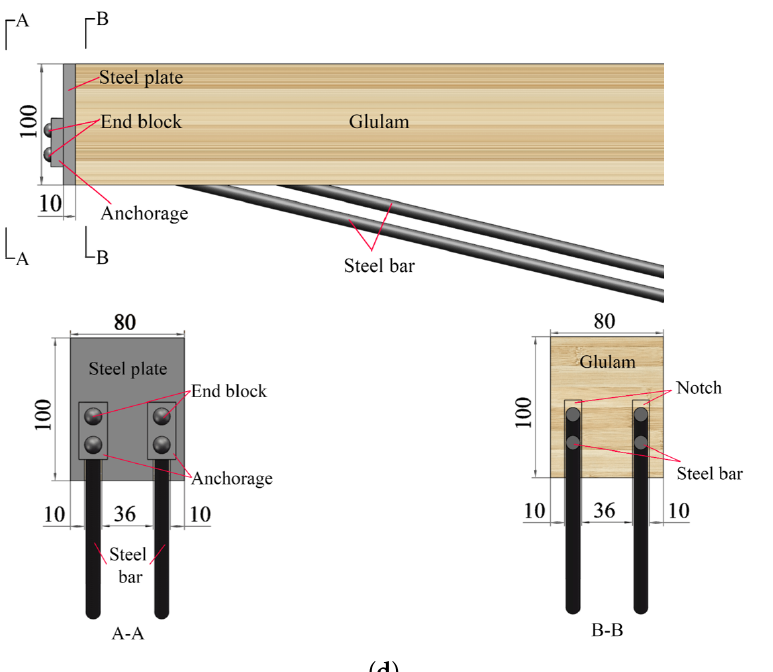
Figure 3. Four types of anchorage devices (dimensions are presented in (mm)). ( a ) mode I: external anchorage device, ( b ) mode II: boot anchorage device, ( c ) mode III: under beam anchorage device and ( d ) mode IV: slotted anchorage